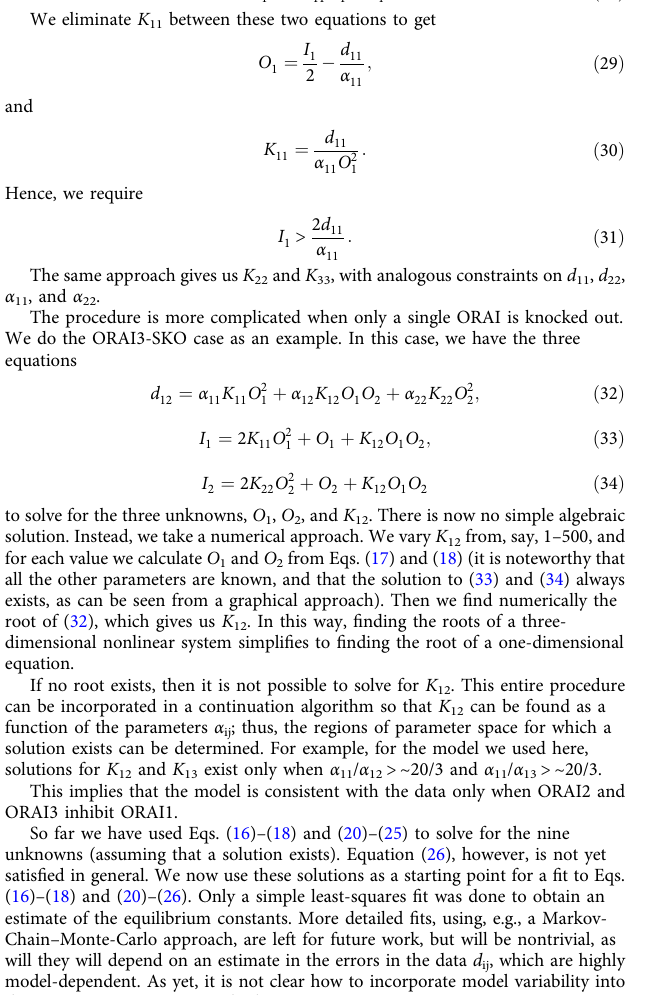
values. Figure 6a, b, c show model responses to increasing agonist concentrations (equivalent to increasing values of p ) for the WT cells and for a selection of ORAI knockouts. In every case, an increase in agonist causes an increase in oscillation frequency, a slightly raised baseline to the oscillations, and, eventually, termination of the oscillations in a raised plateau. Panel a shows that when ORAI1 and ORAI2 are knocked out, the oscillation frequency decreases dramatically, but that ORAI3 is still capable of mediating sustained oscillations. Panel b shows that the ORAI1- SKO case has greatly decreased oscillation frequency, while the ORAI2-SKO case has a frequency only slightly decreased from the WT case in panel a. Panel c shows that when all the ORAI are knocked out, oscillations can still be sustained for a small number of peaks, but that when only ORAI2 and ORAI3 are knocked out, oscillation frequency increases from WT, and the plateau happens at lower agonist concentrations. Panel d shows the model simulation of experiments in which thapsigargin was applied to the cell in the absence of external Ca 2 + , and then, once the cell was emptied of Ca 2 + , external Ca 2 + was reapplied. The resultant Ca 2 + in fl ux is a measure of the CRAC current. The ORAI1,2-DKO current (which is current only through ORAI3) is extremely small, but is still large enough to support sustained oscillations, as shown in panel a. Conversely, the ORAI2,3-DKO current is much larger than the WT current, which implies that there is less Ca 2 + in fl ux when ORAI2 and ORAI3 are present also. Taken together, these model results suggest that (1) ORAI2 and ORAI3 inhibit Ca 2 + in fl ux through ORAI1, (2) very small Ca 2 + entry through ORAI3 channels is suf fi cient to support Ca 2 +